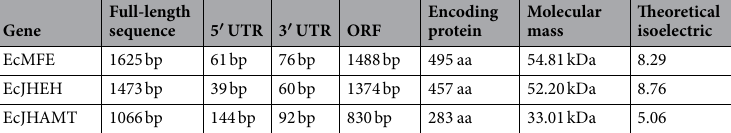
(Figure S3A). To investigate the phylogenetic relationship of the three proteins (EcMFE, EcJHEH and EcJHAMT) and its orthologs, we constructed phylograms based on 9 MFEs (Figure S1B), 17 JHEHs (Figure S2B) and 12 JHAMTs (Figure S3B) protein sequences of insects from GenBank, respectively.